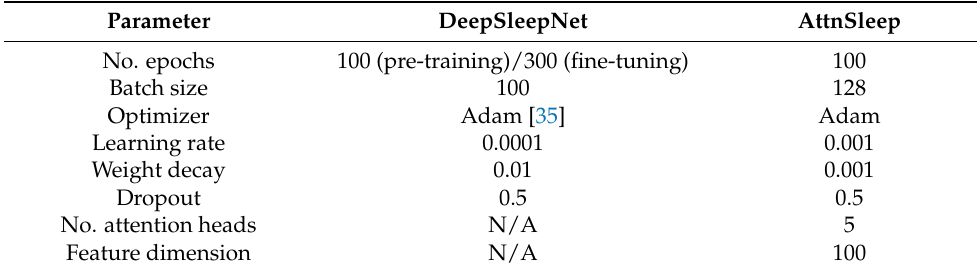
Table 1 . Parameter settings of the DeepSleepNet and AttnSleep methods. Table 1. Parameter settings of the DeepSleepNet and AttnSleep